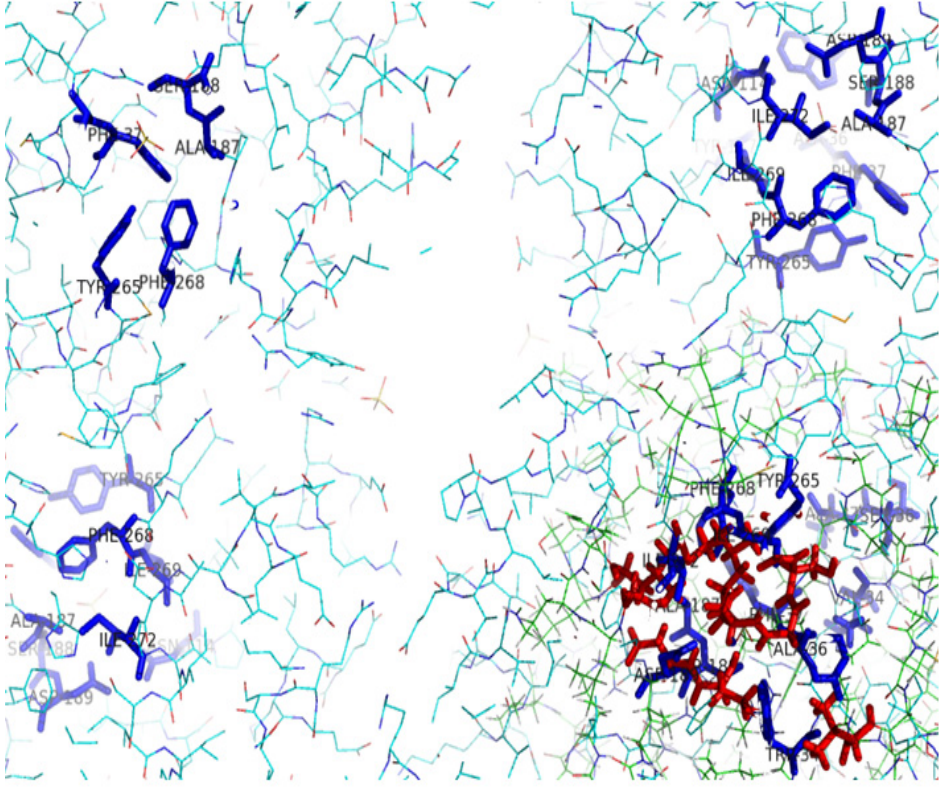
Figure 11. The active site of DehD superimposed onto that of DehI from Pseudomonas putida strain PP3. The catalytic residues of DehI from Pseudomonas putida strain PP3 are shown with blue sticks, and the catalytic residues of DehD with red